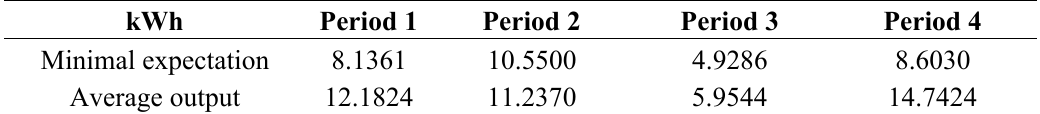
Table 1. The capacity comparison of the two methods.